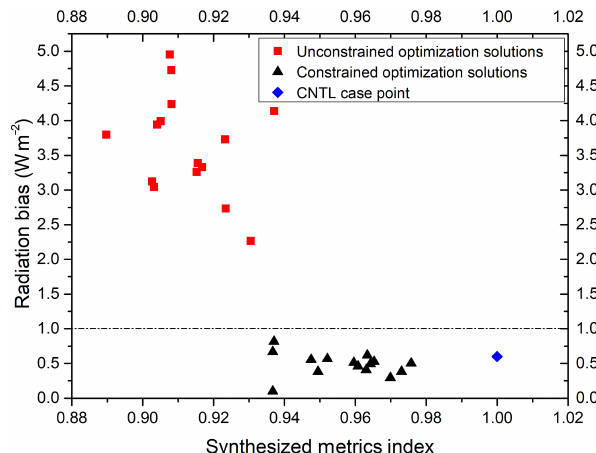
Figure 2. Comparison of results between the constrained optimiza- tion algorithm and the unconstrained optimization algorithm. The 15 red squares and 15 black triangles are optimized solutions found by the unconstrained optimization algorithm and constrained algo- rithms, respectively. The blue diamond is the result of the CNTL experiment. The x axis is the synthesized metric index in Eq. (3). The y axis is the radiation bias at the top of the